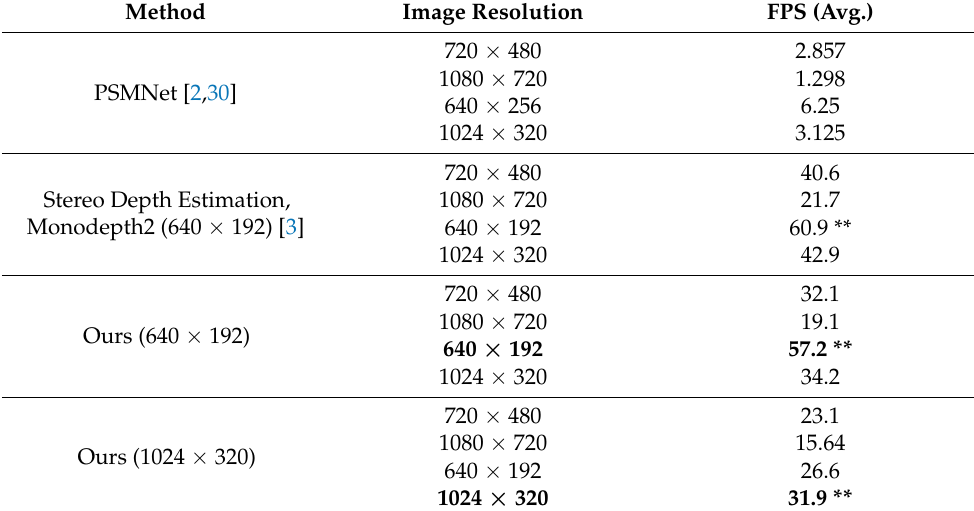
Table 4. Average processing speed.